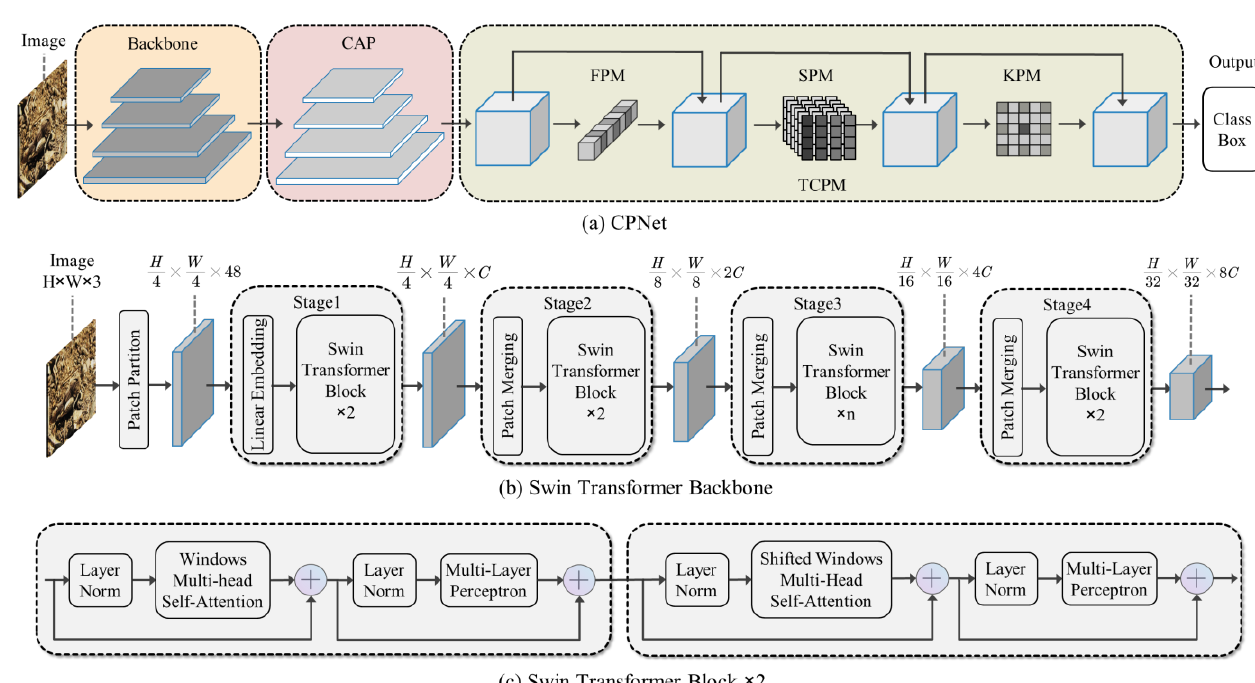
Figure 3. Cascade perception network (CPNet) structure.